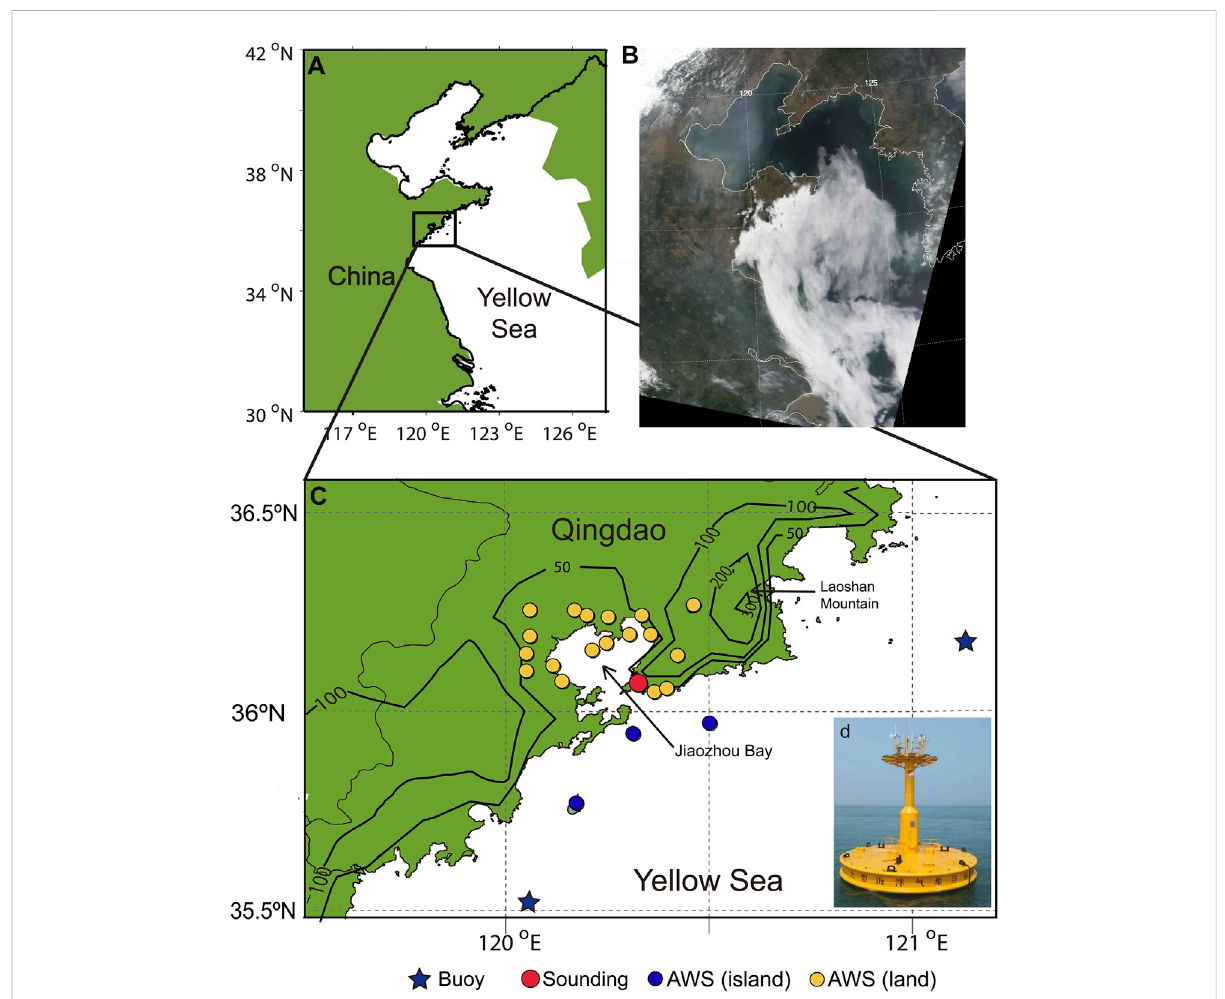
FIGURE 1 Locationsofbuoys,soundingstations,andautomaticweatherstations(AWSs)usedinthisstudy (A,C) .Blackcontourrepresentstopography(m). There are three AWSs on the island (blue dots) and 19 AWSs on land (yellow dots). Only 21 AWSs are visible because one overlaps with the sounding station. Panel (D) shows the buoy near Qingdao. Panel (B) is a visible image of the MODIS swath scan at 0315 UTC 1 May 2015 during an SFP